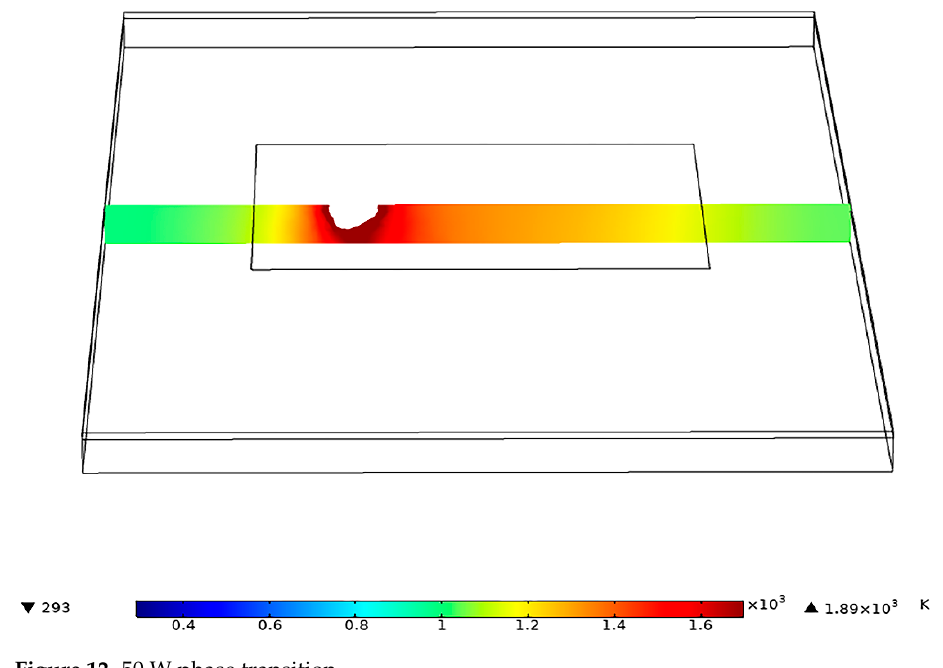
Figure 12. 50 W phase transition.